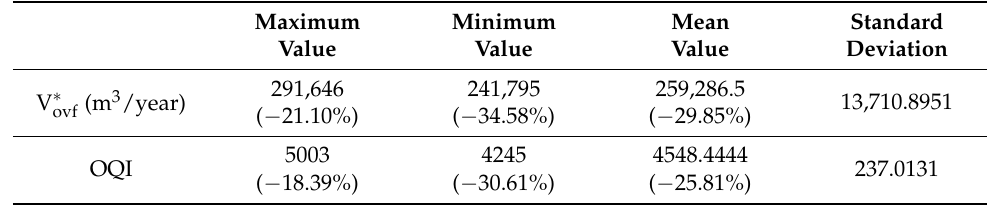
Table 19. Statistical